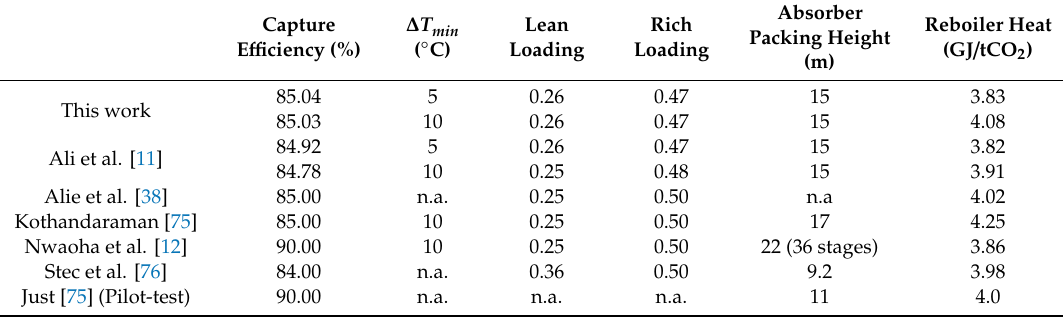
Table 5. Process simulation results-comparison with literature.